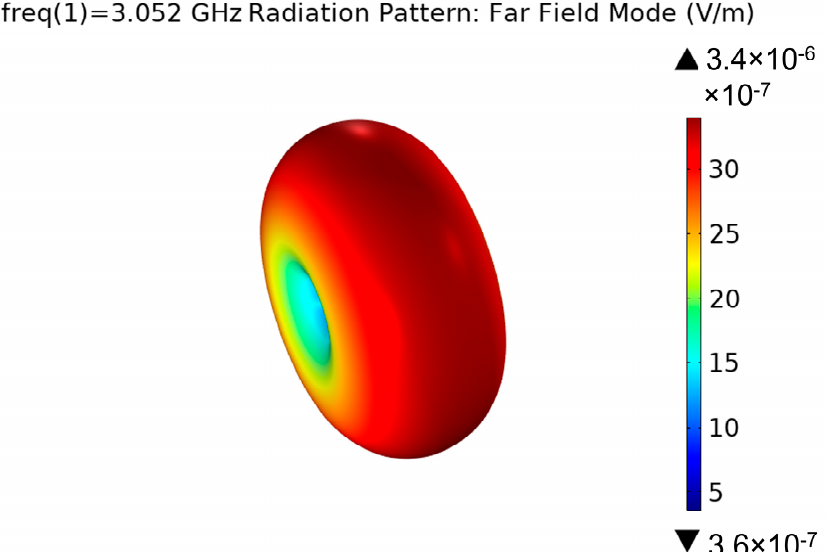
Figure 11. Far-field 3D pattern of the antenna.